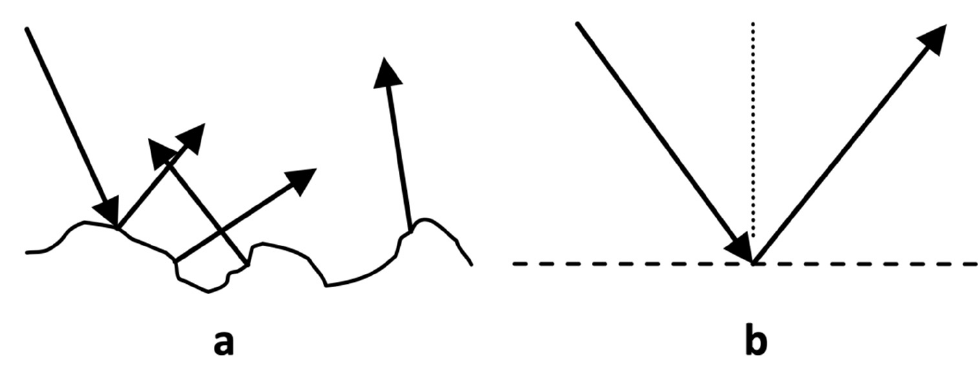
Figure 1. Two types of specular (Fresnel) reflection from tissue. Specular reflection from a rough surface (i.e., Lambertian reflectance) ( a ) and smooth surface ( b ) .